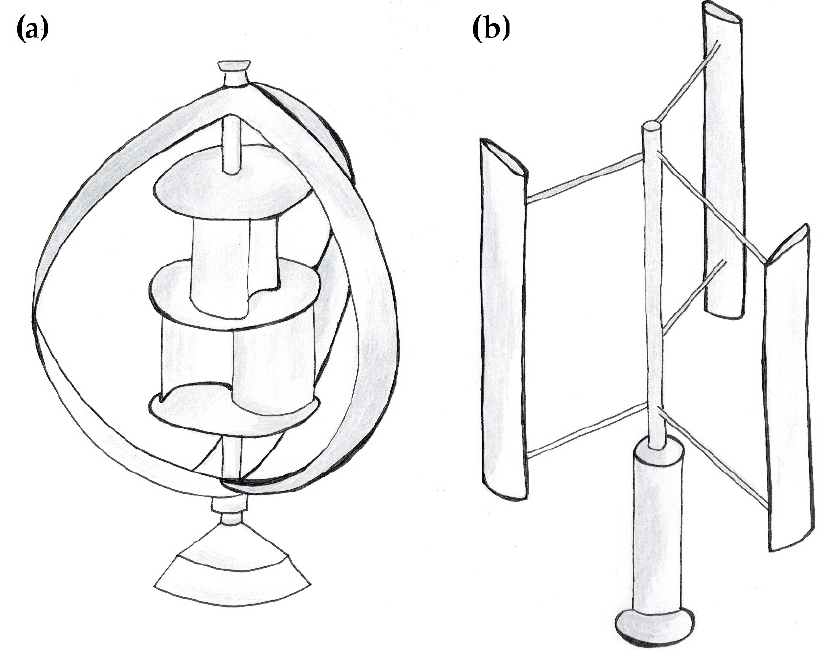
rotor—Figure 9b. Power curves of both turbines are shown in Figure 10. Basic technical data of both turbines are summarized in Table 1.